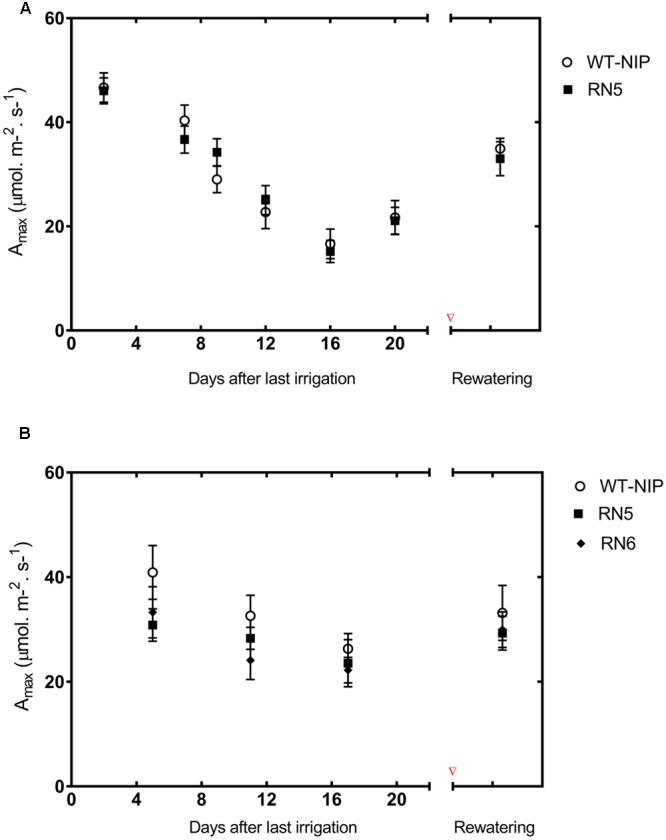
Drought-induced changes in CO2 saturated photosynthesis rate (Amax) during Trials 2 (A) and 3 (B). Regular measurements were taken during the drought stress period. Experimental plots were re-irrigated when leaves started to fold, and Amax was measured again 10 days later. [CO2]ambient = 1800 mmol/mol, photosynthetic photon flux intensity = 1500 mmol/m2/s, RH = 60%, LeafTemp = 28°C